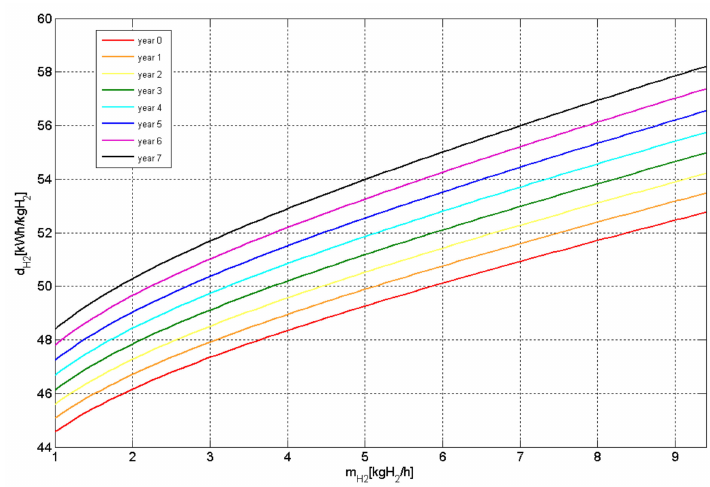
Figure 7. Influence of the years of operation on the specific energy consumption by an electrolyzer for the production of 1 kg of hydrogen—own study.